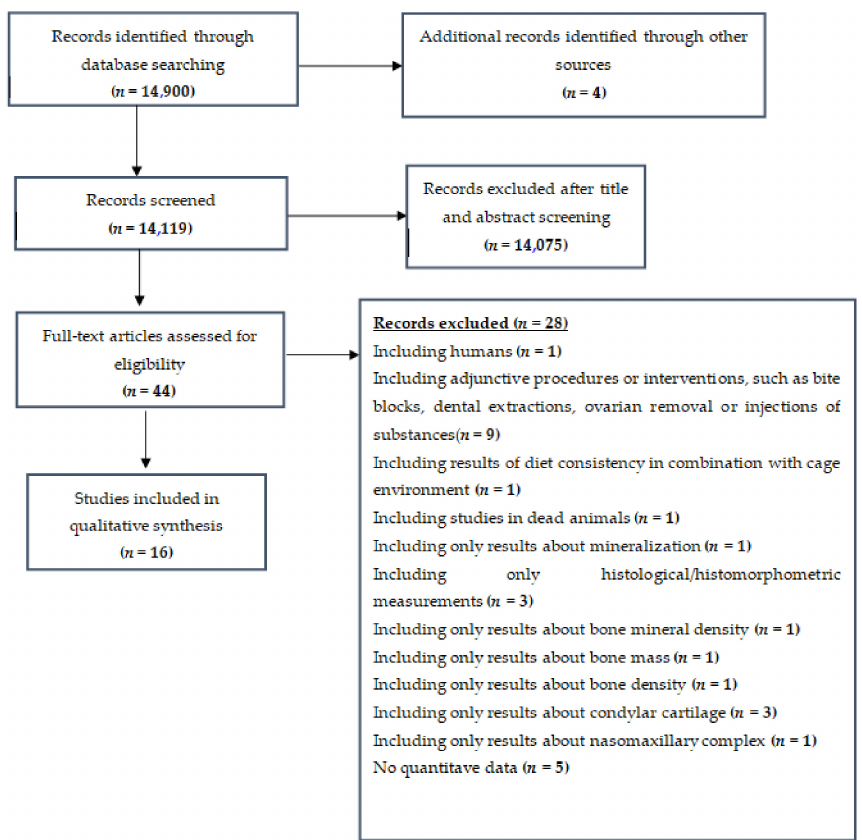
Figure 1. Flowchart—Detailing inclusion/exclusion of